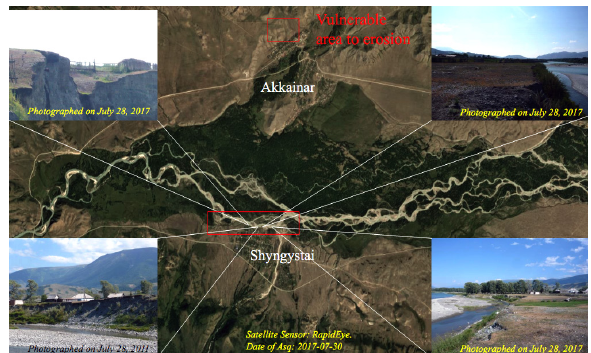
Figure 1. The erosion of the territory of Shyngystai